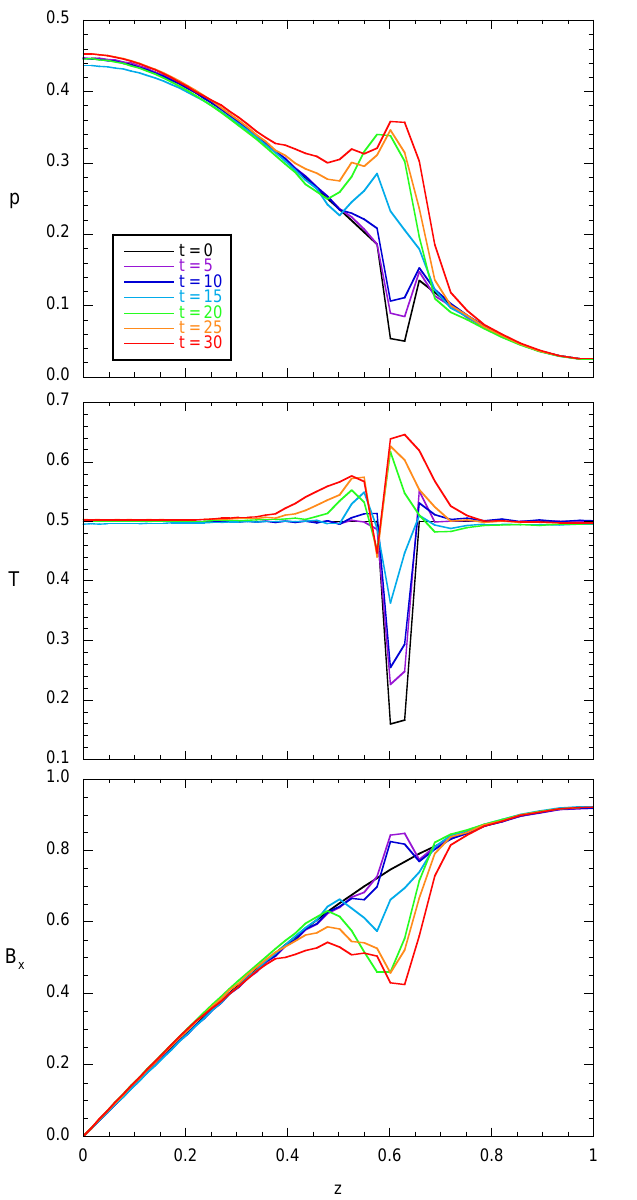
Fig. 6. Evolution of the near-Earth part of the depleted flux tube of Fig. 5, showing (from top to bottom) the plasma pressure, tem- perature, and the magnetic field component B x with y m = 0 . 2 at x =− 1 . 0, y = 0 as functions of z for different times, as indicated by the color coding. Note that the initial pressure and temperature reduction and magnetic field enhancement become reversed as the flux tube fills through earthward flow and expands in the y and z directions.